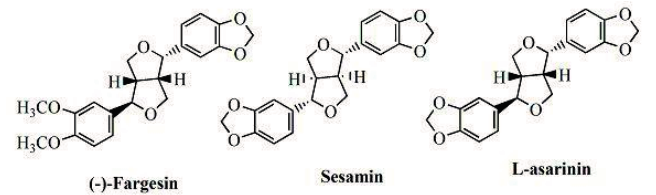
Figure 1. Chemical structures of three major lignans in Zanthoxylum armatum .